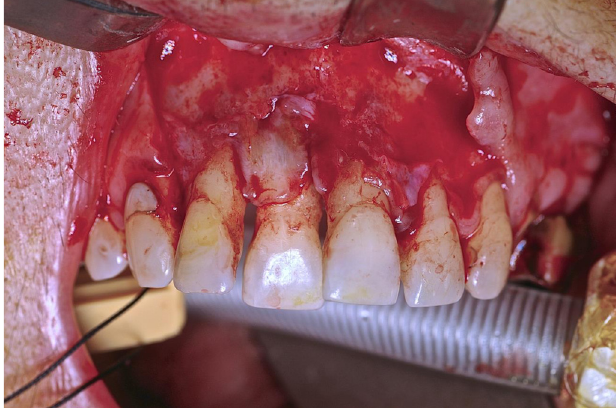
Fig. 5. Endobuccal view of the surgery site after closing.